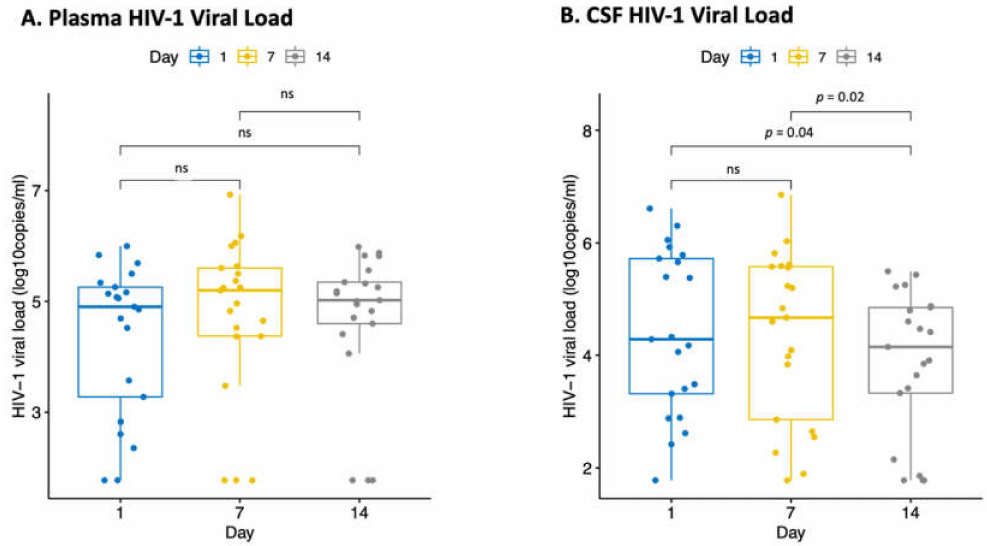
Figure 2. ( A ) Boxplots comparing median plasma HIV-1 viral load between days 1, 7 and 14 for each participant with complete follow-up data (combining all the three treatment decision groups). ( B ) Boxplots comparing median CSF HIV-1 viral load between days 1, 7 and 14 for each participant with complete follow-up data (combining all the three treatment decision groups). Table 3. Factors associated with changes in the CSF and plasma HIV-1 viral load over time ( n = 83). CSF PLASMA Univariable Multivariable Univariable